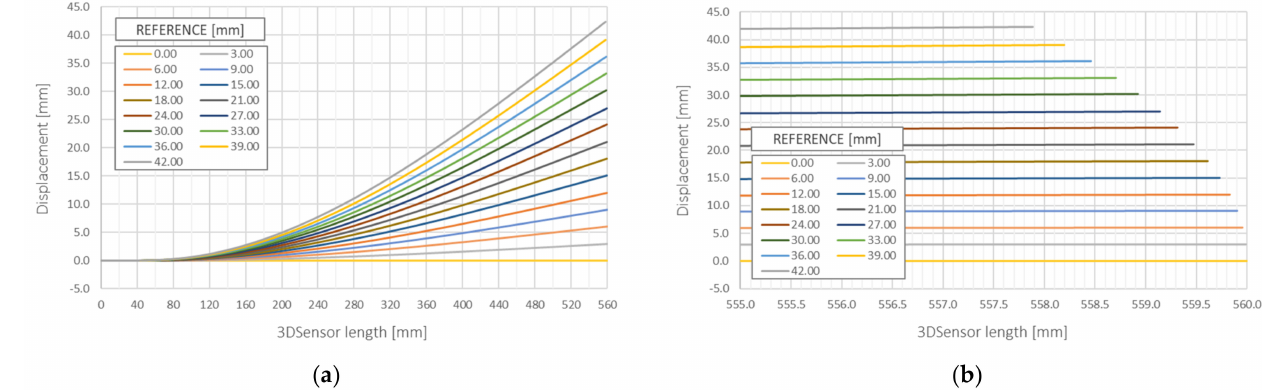
Figure 15. Measurement results: ( a ) vertical displacements in full scale of horizontal axis; ( b ) close up to the end of the specimen with visible shortenings along horizontal axis caused by large vertical displacements (compare Figure 14b).